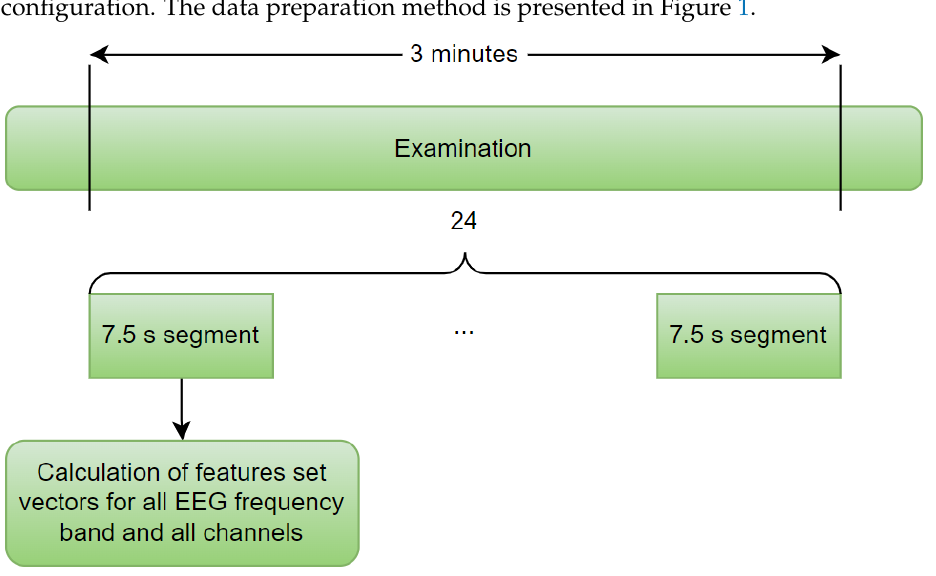
Figure 1. Data preparation path.